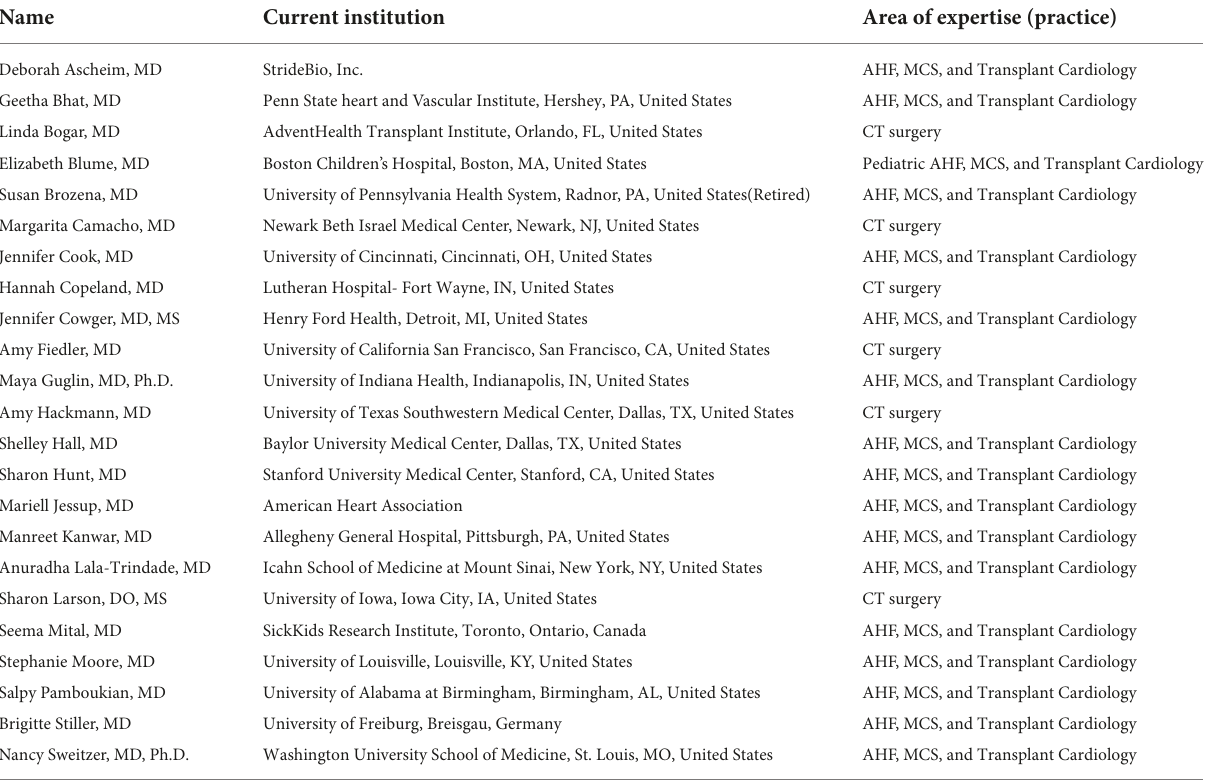
TABLE 1 List of interviewees for this review and their current affiliated